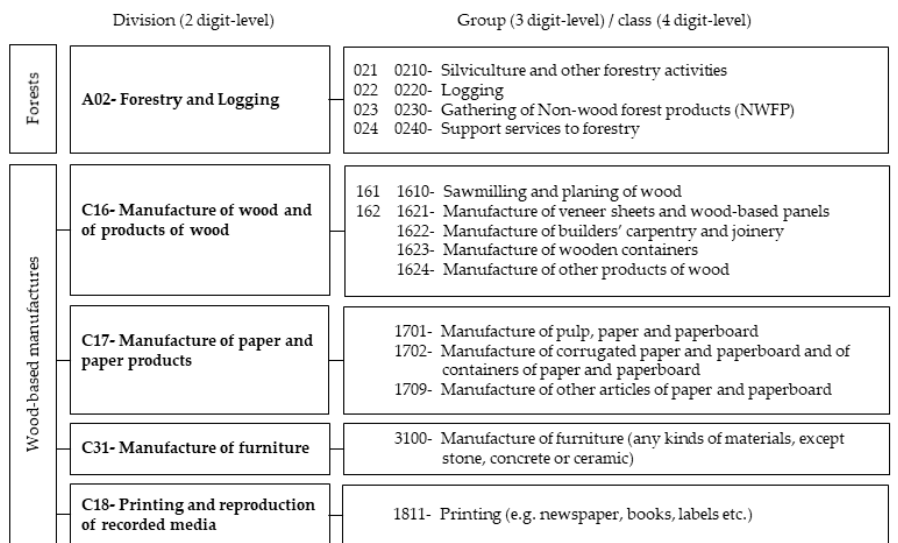
Figure A1. Forest sector definition corresponding to ISIC Revision 4. Source: constructed based on [11]. Table A1. Pairwise correlation coefficients for cluster attribute variables.